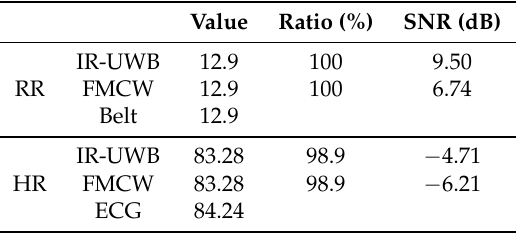
Table 13. RR and HR results under a heavily cluttered environment.